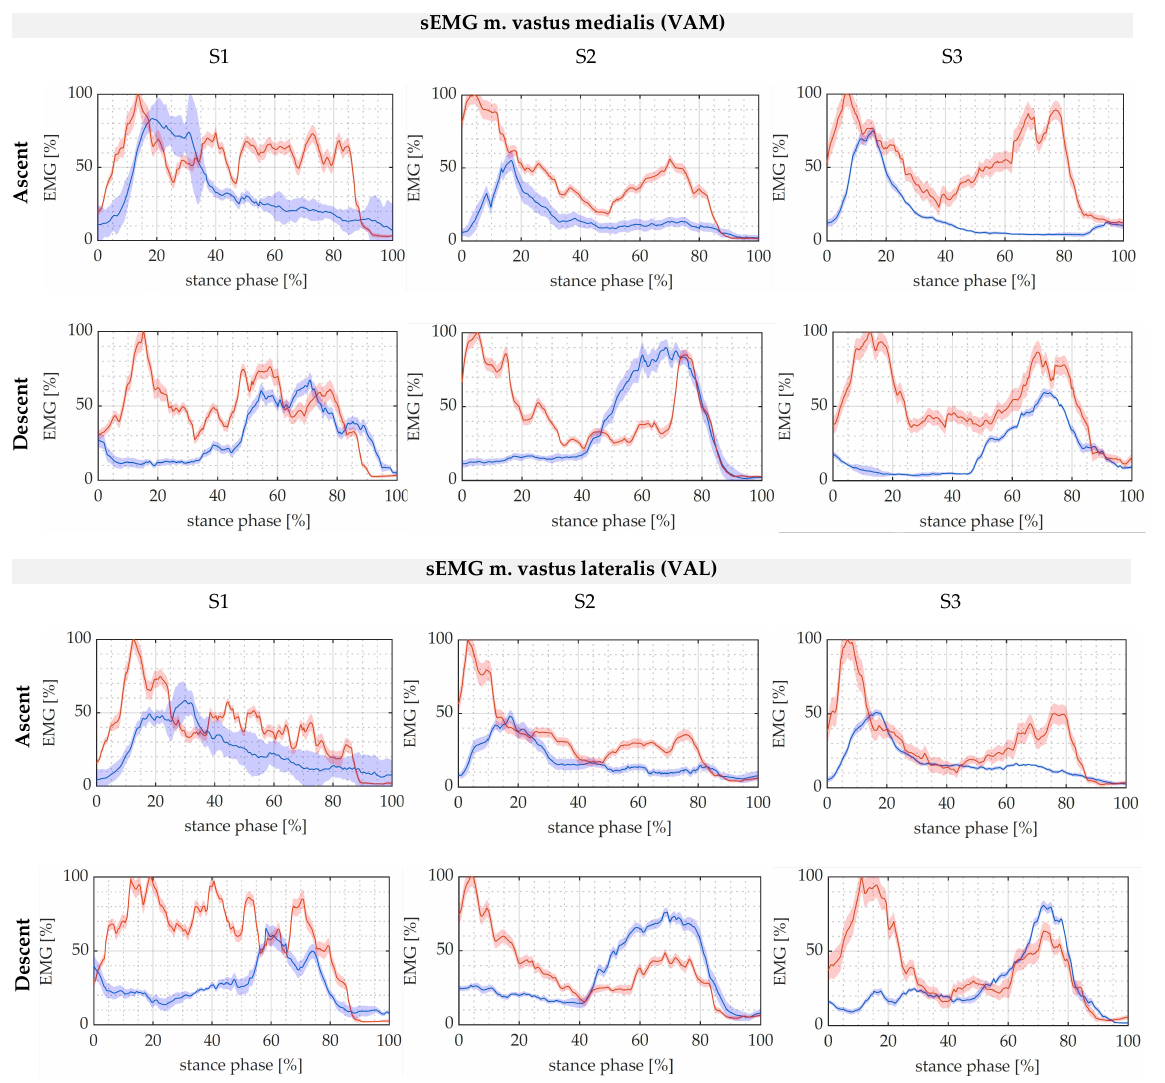
Figure 10. sEMG curves of m. vastus medialis (VAM) and m. vastus lateralis (VAL) in stance phase for ascent and descent without (red) and with (blue) the exoskeleton for Subject 1 ( left ), Subject 2 ( middle ), and Subject 3 ( right